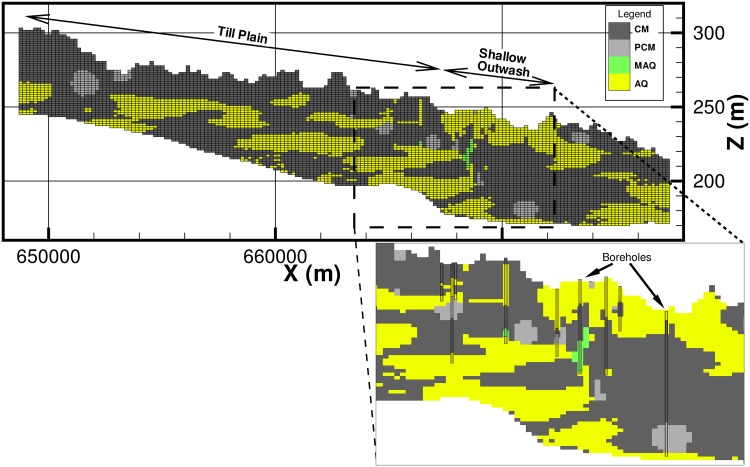
View of cross-section AB (Fig 4) from the geologic model showing the borehole data.